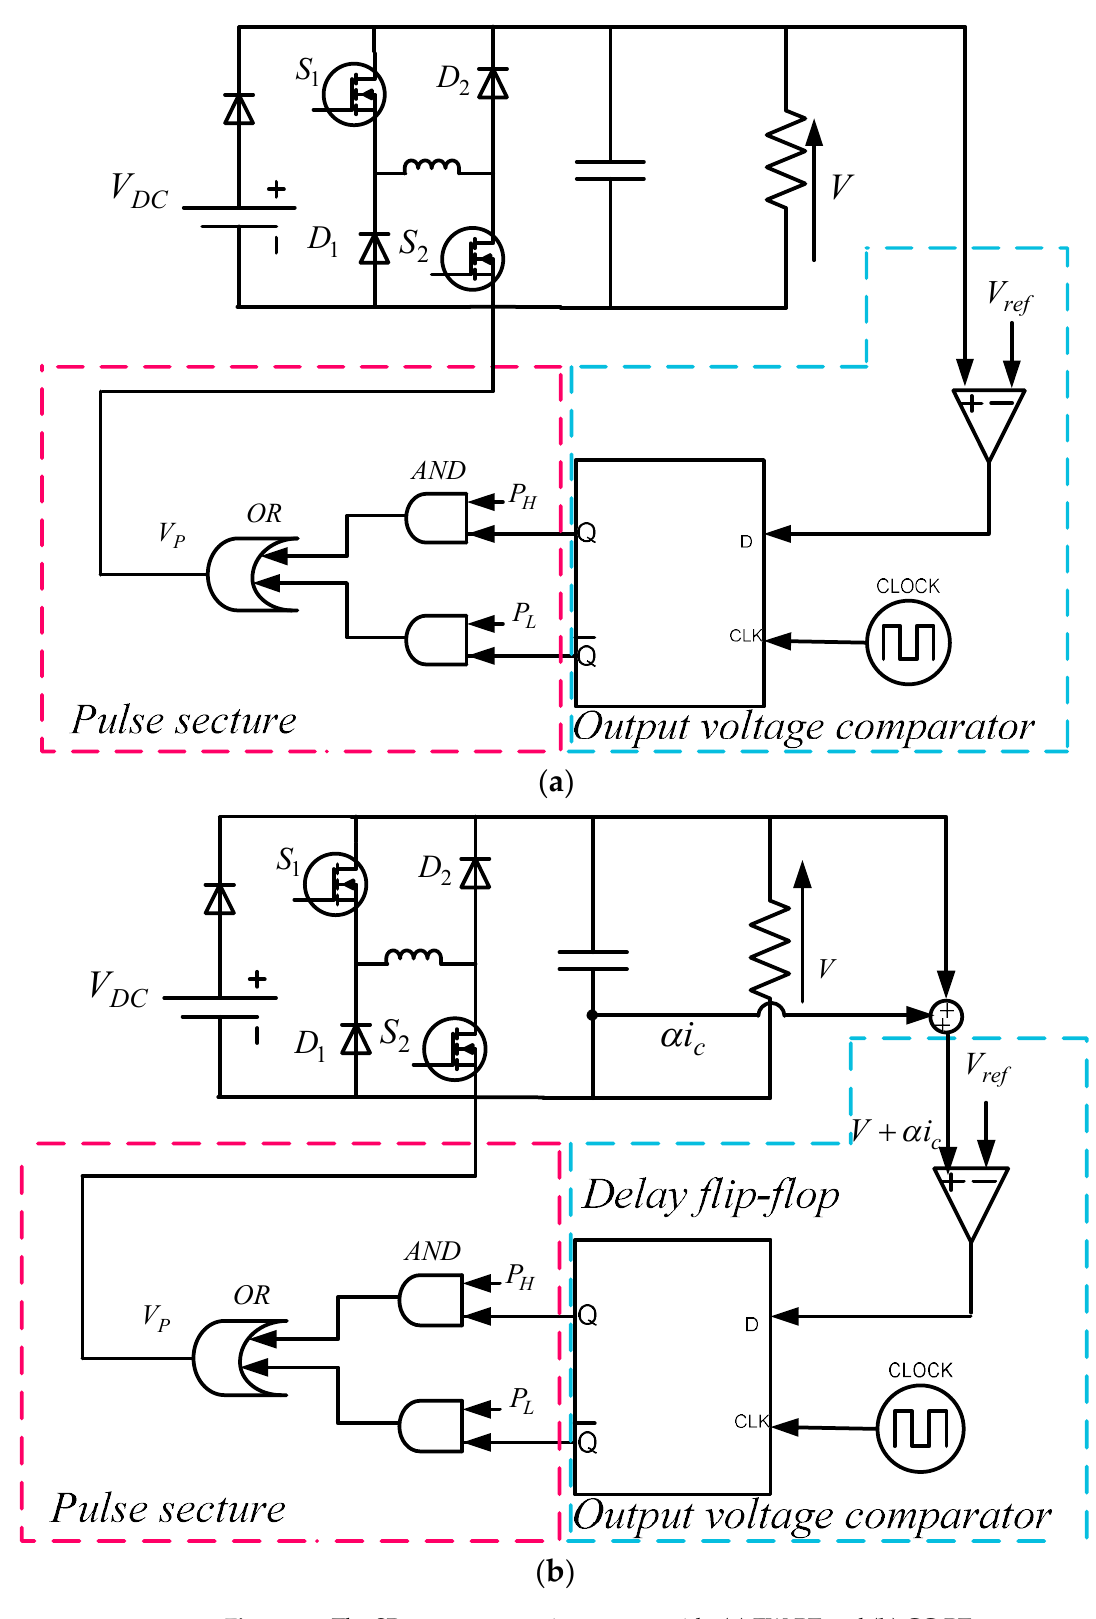
Figure 17. The SR power generation system with: ( a ) FW-PT and ( b ) CC-PT.